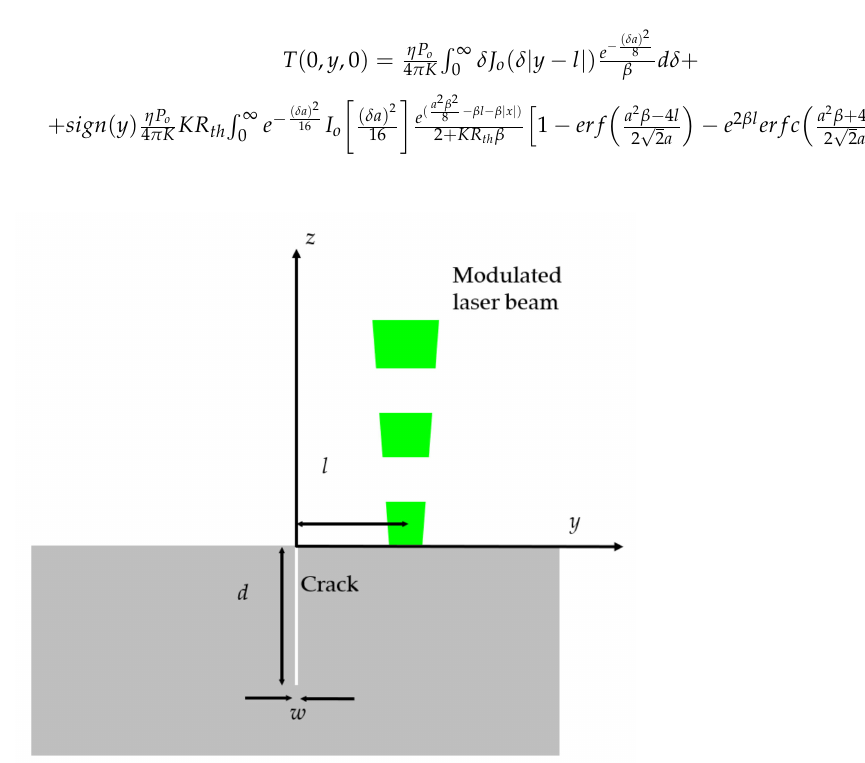
Figure 1. Cross-section of the sample with a vertical surface-breaking crack. Here, η is the laser power fraction absorbed by the sample, β = and I o are the Bessel function and the modified Bessel function of order zero, respectively; and erf and erfc are the error function and the complementary error function, respectively. Sign ( y ) is − 1, 0, or 1 depending on whether y is negative, zero, or positive,